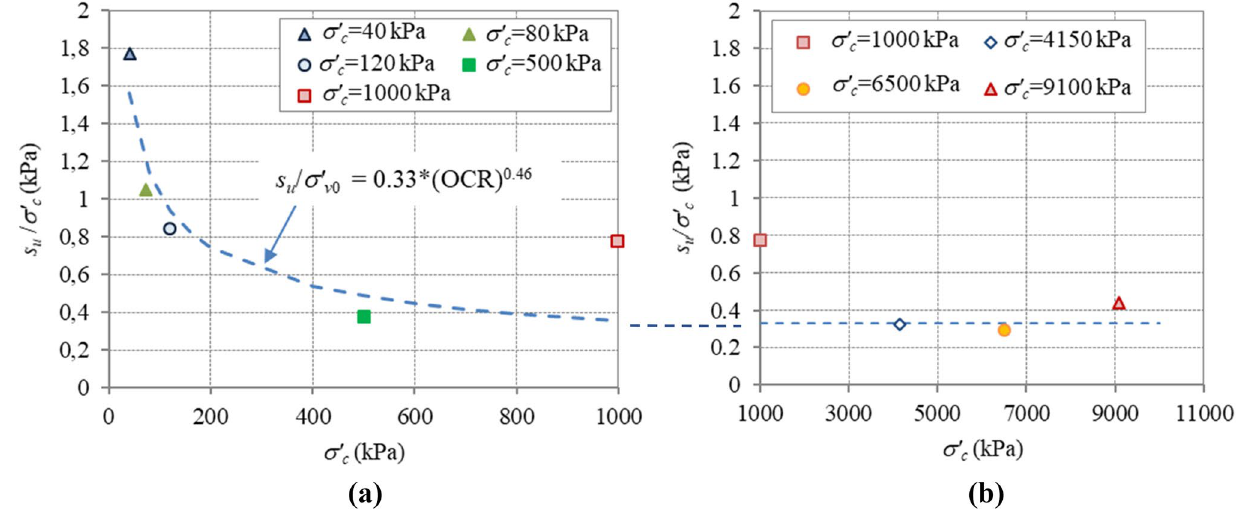
Fig. 11 Undrained shear strength normalized by the test effective consolidation stress versus effective consolidation stress: a overconsoli‑ dated samples; b normally consolidated